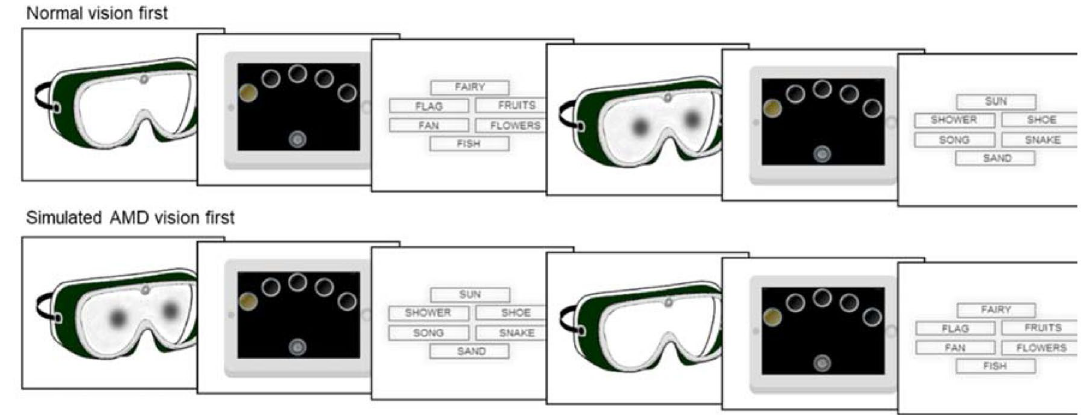
Figure 2. Participants completed the reaction time task and verbal fluency test under their assigned vision condition (normal or simulated AMD), then repeated the tasks under the opposite vision